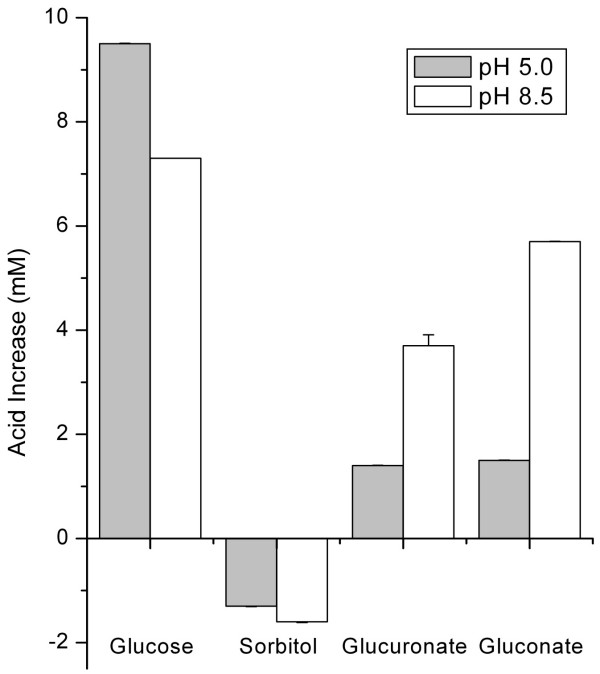
Acid production during supplementation with different carbon sources. The net acid produced or consumed by each culture was determined as described (see Methods).